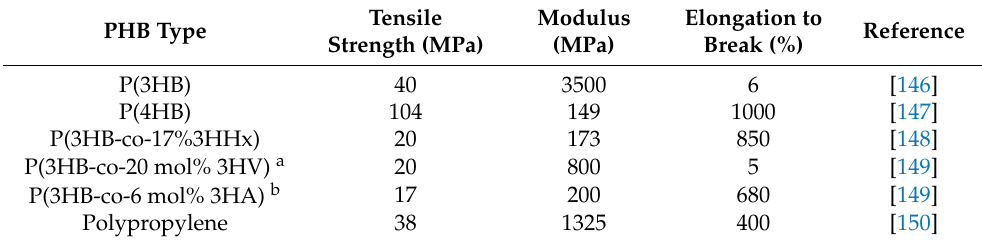
Table 3. Mechanical properties of various types of